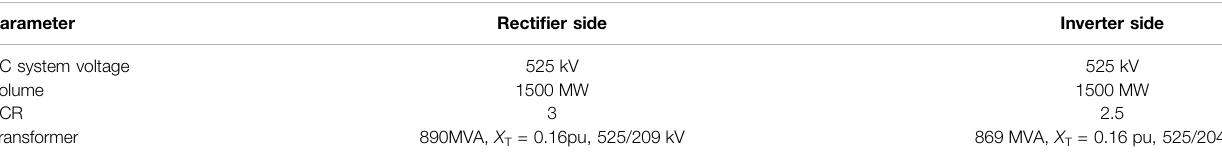
TABLE 1 | LCC-HVDC system